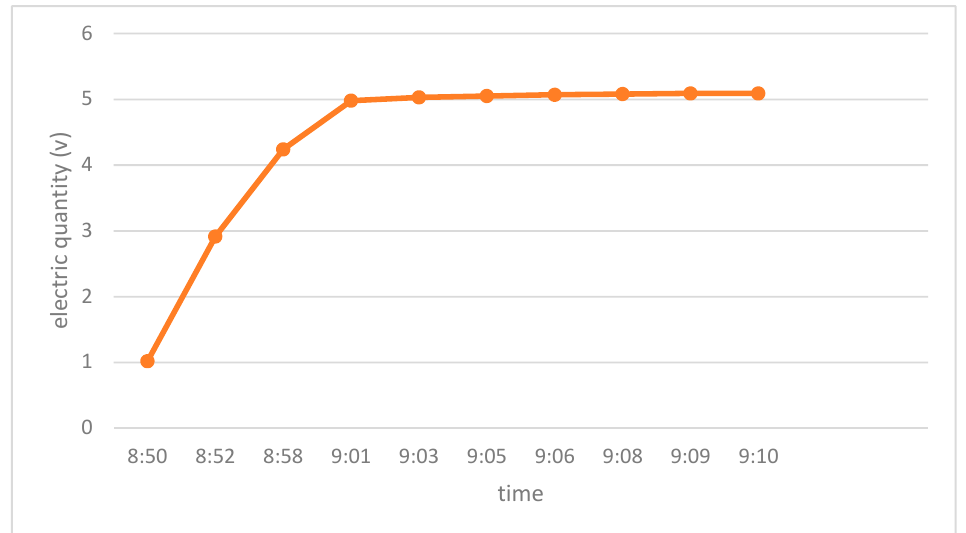
Figure 16. The charge curve of the photovoltaic subtle energy-powered RFID tag adopted in the proposed system. This experiment was conducted in a cloudy day. The luminance ranged between 23,000 lux and 26,000 lux during the test period of time. The RFID tag was fully charged at 09:09, and the whole charging process took around 20 min.